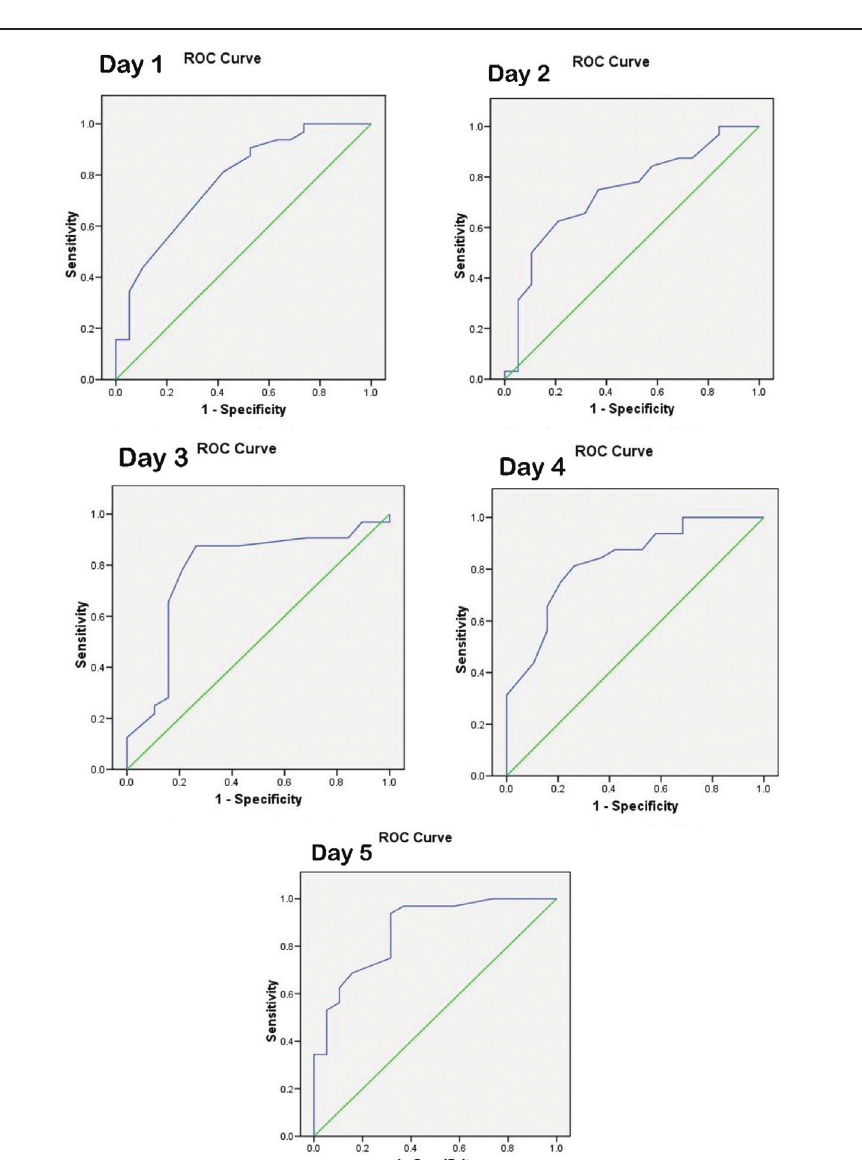
Receiver operating characteristic analysis of the EtCO 2 gradient and predicted mortality.